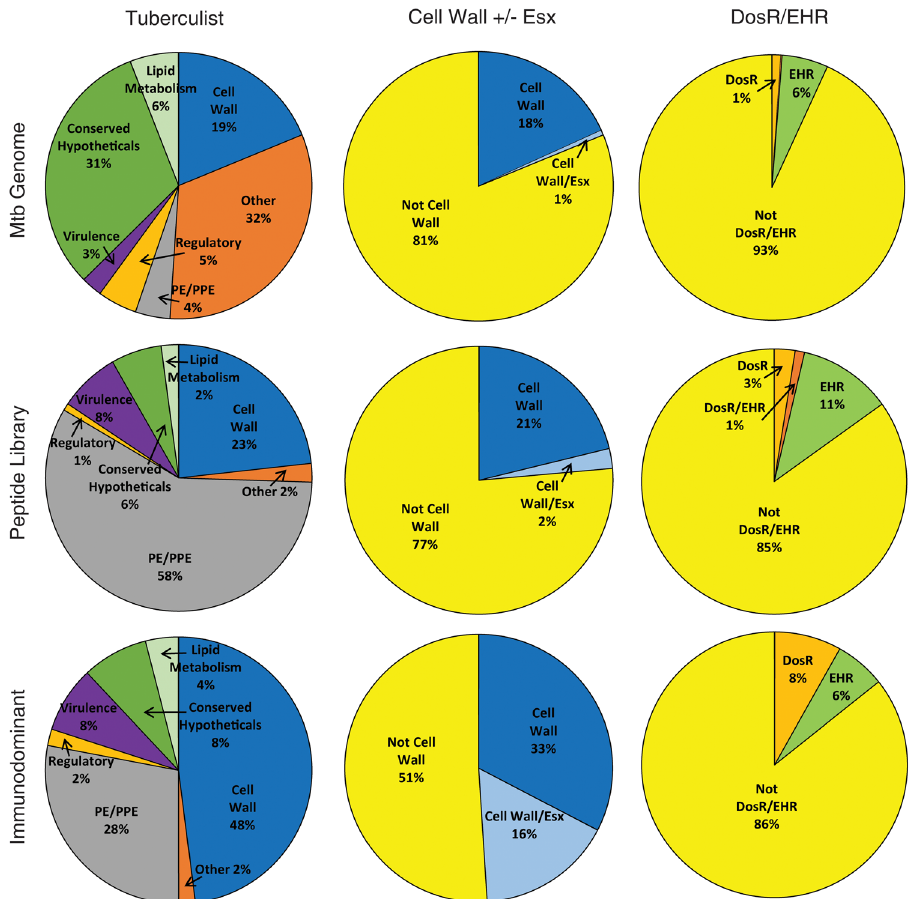
Fig. 2 Composition of the Mtb genome, peptide library and immunodominant peptide pools according to functional classi fi cations. For the Mtb genome, peptide library, and set of immunodominant peptide pools, the proportion of proteins categorized by Tuberculist functional classi fi cation, or categorized as an Esx family member or not, or DosR/EHR family member or not is shown. Using hypergeometric distribution, the probability of observing at most 14 peptide pools representing PE/PPE proteins out of 49 immunodominant peptide pools by chance given the high (58.8%) prevalence of peptide pools representing PE/PPE proteins in the library is 0.00098%. The probability of observing ≥ 24 peptide pools representing cell wall proteins out of 49 by chance when the prevalence in the library is 23.5%, is 0.0053%. The probability of ≥ 8 peptide pools representing Esx proteins out of 49 by chance when the prevalence in the library is 2.4% is < 0.0001. The probability of ≥ 16 peptide pools representing non-Esx cell wall proteins out of 49 by chance when the prevalence in the library is 21.2% is